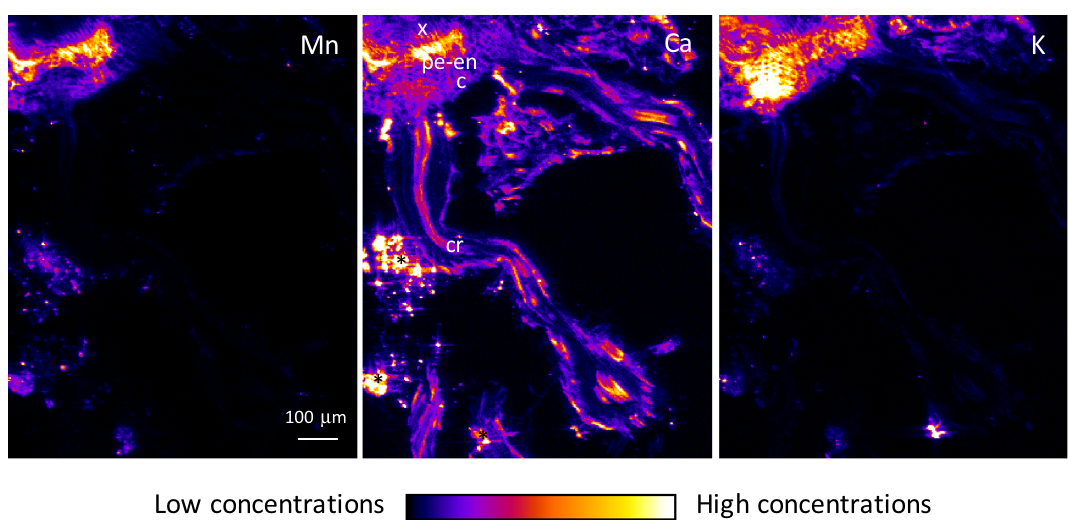
Figure 6. μXRF maps of Mn, Ca and K for a cross-section of frozen hydrated cluster root of transplanted Grevillea meisneri . The pixel size is 3 μm. The intensity scales are different between elements. c cortex, cr cluster rootlet, p phloem, pe–en , pericycle–endodermis, x xylem. Asterisks indicate soil